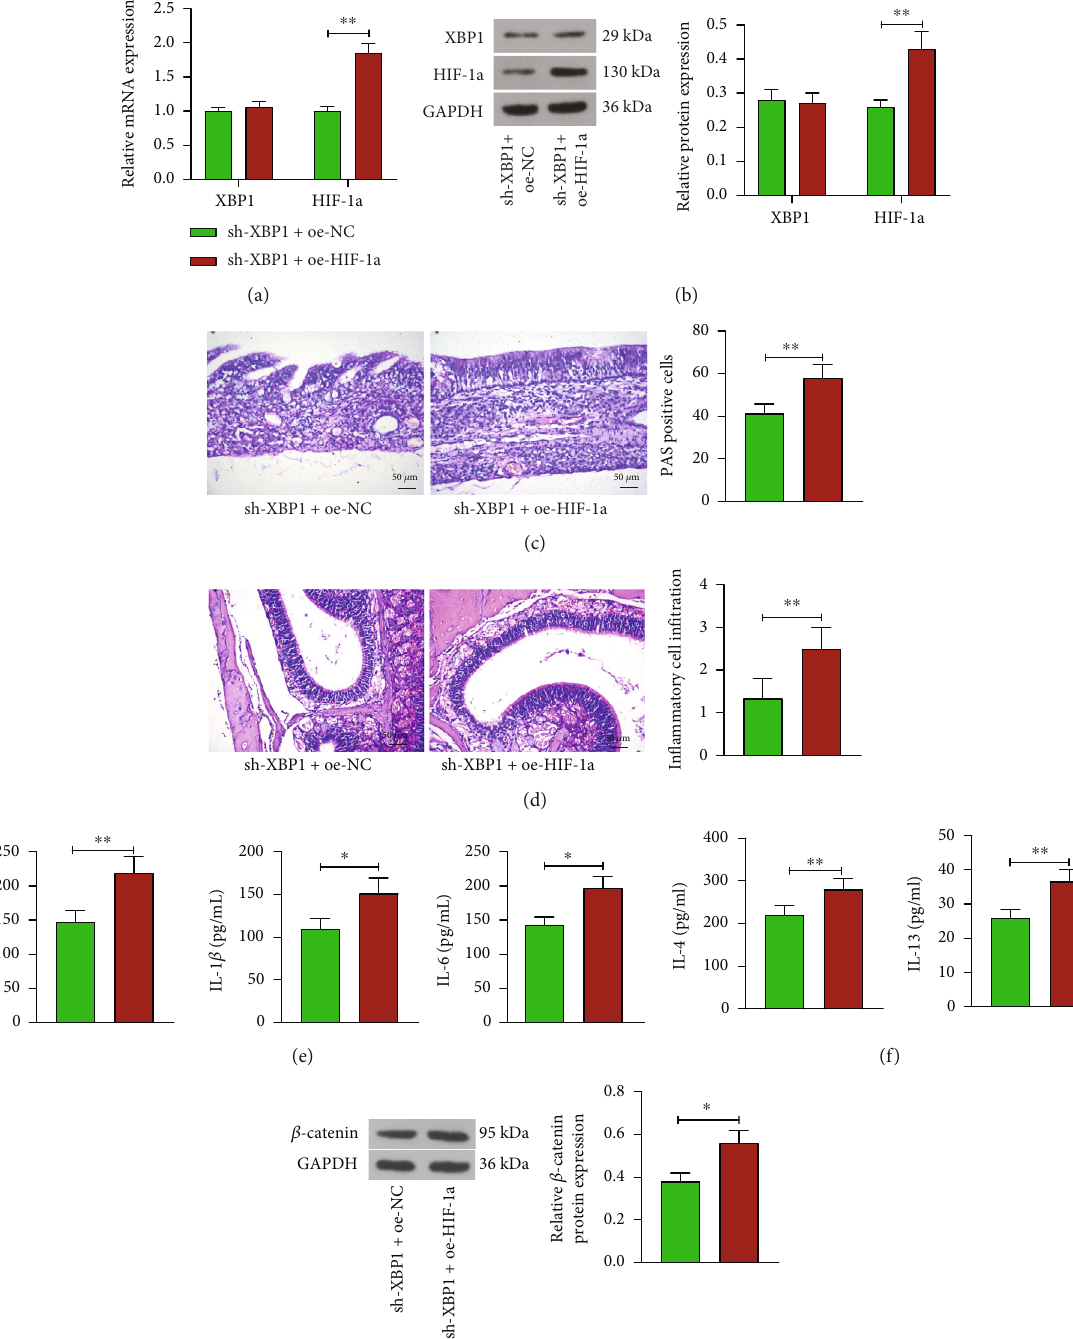
Figure 5: Overexpression of HIF-1a reverses the alleviating e ff ect of sh-XBP1 on the development of CRSsNP in mice. (a, b) Analysis of mRNA and protein expression of XBP1 and HIF-1a after further overexpression of HIF-1a in CRSsNP mice with silenced XBP1 expression by (a) RT-qPCR and (b) Western blot. (c) PAS staining analysis of mucin expression in nasal mucosal epithelial cells of mice. (d) Pathological changes of nasal mucosa in mice observed by HE staining. (e) The levels of in fl ammatory factors IFN- γ , IL-1 β , and IL-6 in nasal mucosal tissues of mice measured using ELISA. (f) The levels of in fl ammatory factors IL-4 and IL-13 in nasal mucosal tissues of mice measured using ELISA. (g) Western blot detection of protein expression of β -catenin in nasal mucosal tissues of CRSsNP mice. ∗ p < 0 : 05 and ∗∗ p < 0 : 01 versus the CRSsNP mice administrated with sh-XBP1+oe-NC. The data are measurement data, presented as mean ± SD . Data between two groups were compared using an unpaired t test. Data among multiple groups were compared using one- way analysis of variance and then analyzed with Tukey ’ s post hoc test. The experiment was independently repeated three times. n = 6